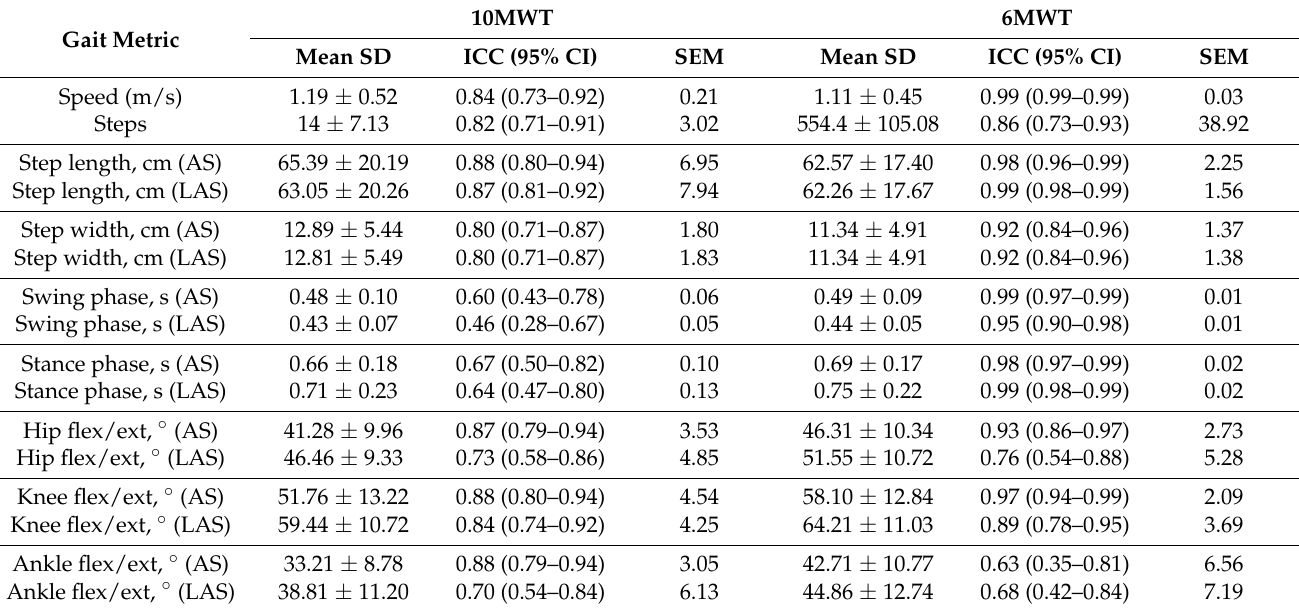
Table 2. Test-retest reliability and measurement error per gait metric and test